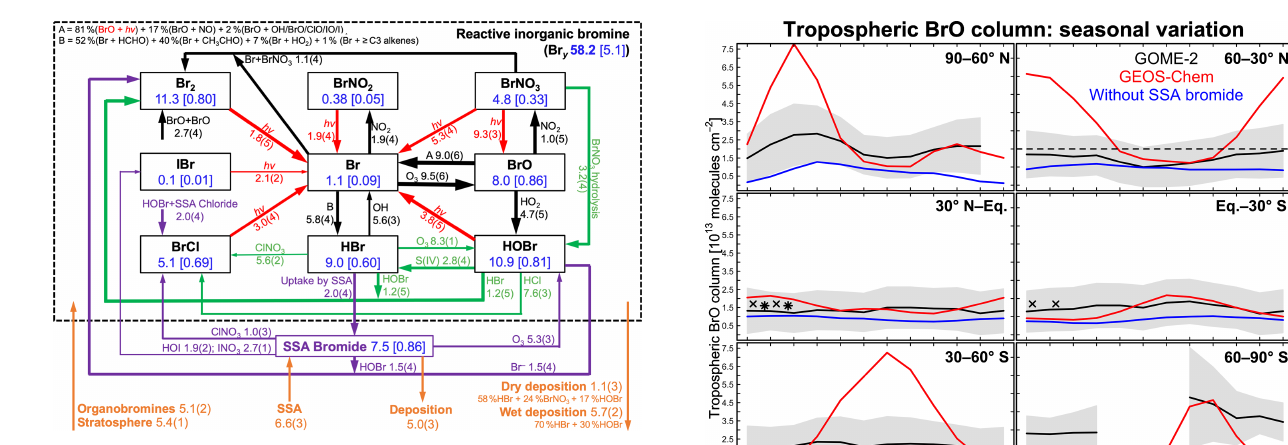
Figure 3. Global annual mean tropospheric budget and cycling of reactive inorganic bromine (Br y ) and sea salt aerosol (SSA) bro- mide. Results are from our GEOS-Chem simulation for 2012 in- cluding SSA debromination. Br y is defined as the ensemble of species inside the dashed box. Rates are in gigagrams of Br per year (GgBra − 1 ), masses in the boxes are in GgBr, and num- bers in brackets are mean mixing ratios (ppt). Read 5.8(4) as 5 . 8 × 10 4 GgBra − 1 . Arrows in black are for gaseous reactions, red for photolysis, purple for heterogeneous reactions in SSA, and green for other heterogeneous reactions taking place in cloud and sulfate aerosol. Sources and sinks of total inorganic bromine (Br y + SSA bromide) are in orange. Arrow thickness scales with its correspond- ing rate.